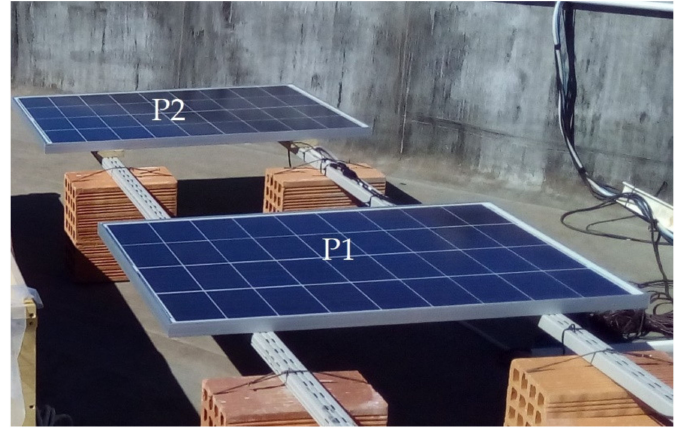
Figure 6. Panels placed under identical